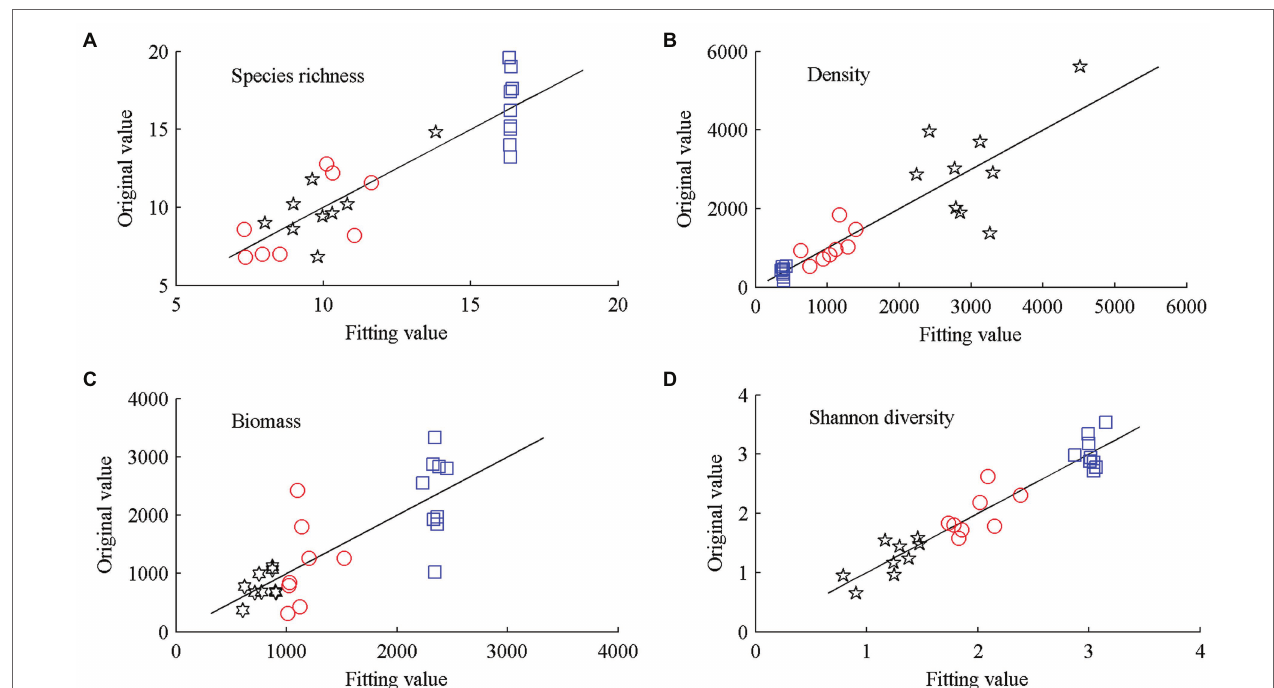
FIGURE 2 | Fitting effects of the PLS models of traits of the three plant communities (black five-pointed star— Carex community, blue square— Miscanthus community, and red circle— Polygonum community). (A) Species richness; (B) Density; (C) Biomass; and (D) Shannon diversity.